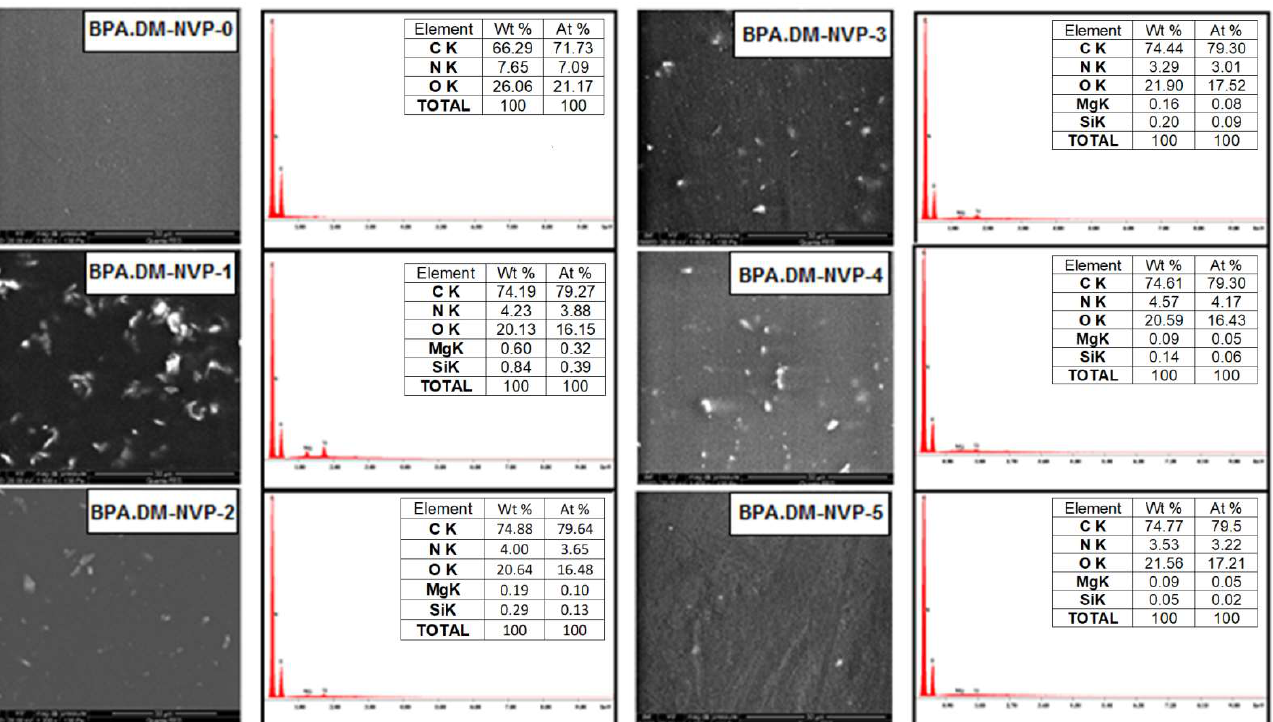
Figure 5. SEM images and SEM-EDX microanalysis of the samples. The area of the tested surface was the same for all samples. The SEM images were obtained using the backscattered electron (BSE) mode. In this mode the images of the sample containing elements with a higher atomic number are mapped to the BSE images as